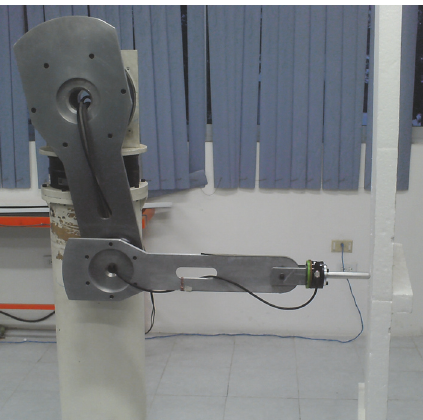
Figure 1: Experimental robot